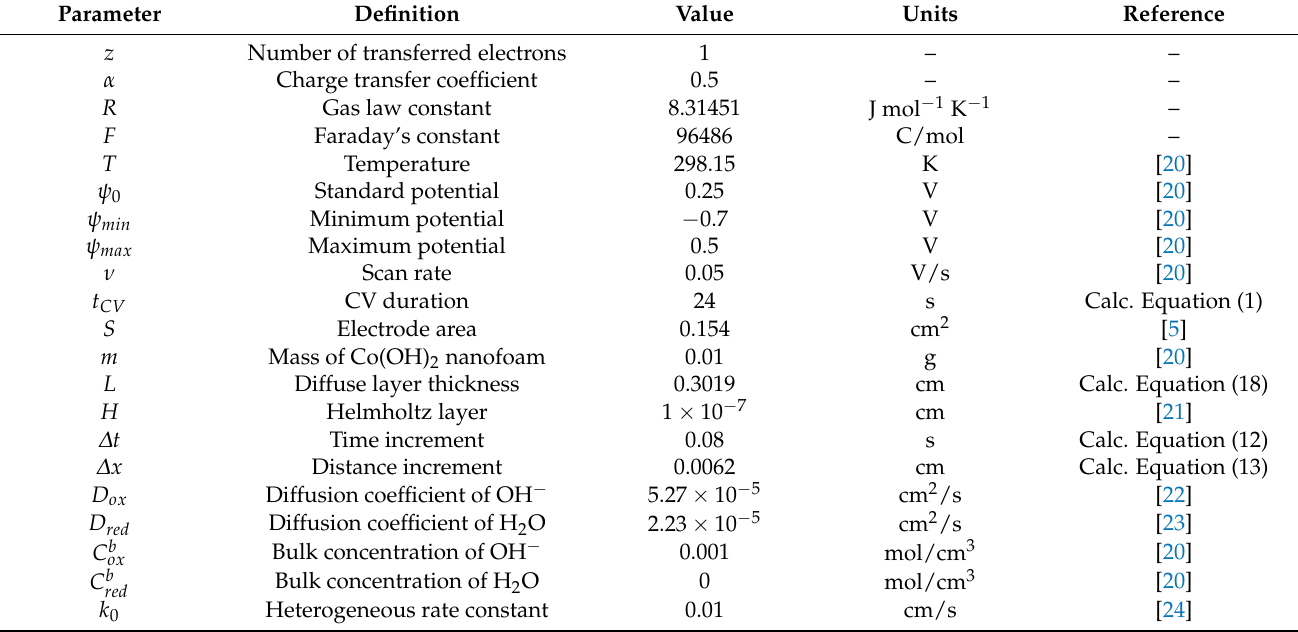
Table 1. Operating conditions of